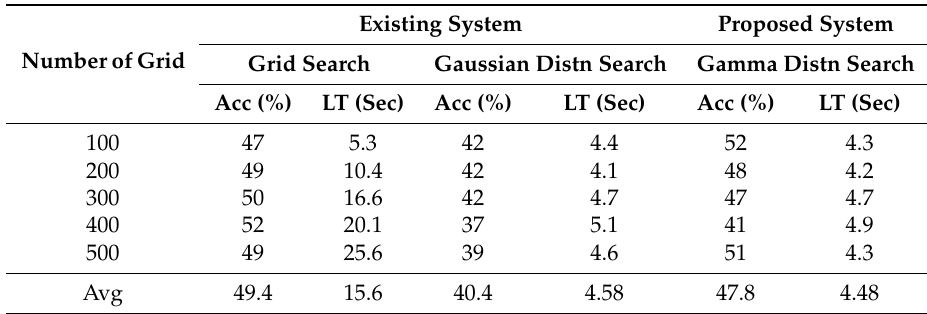
Table 6. Comparison of grid search, Gaussian distribution search and Gamma distribution search, applying 10 counts of optimization and 1 epoch. LT, learning time.